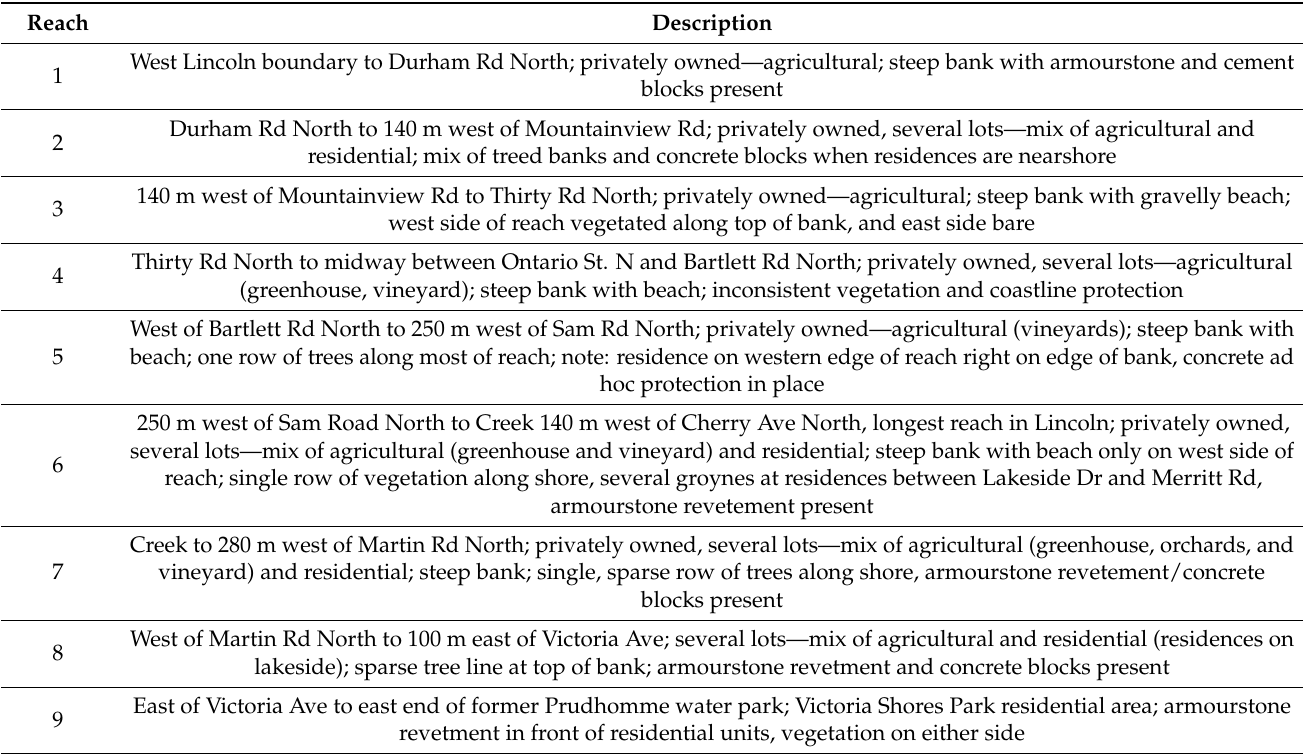
Table 3. A description of each of the 19 reaches within the Town of Lincoln from west to east. Reach boundaries adapted from [46]. Descriptions are based on current land